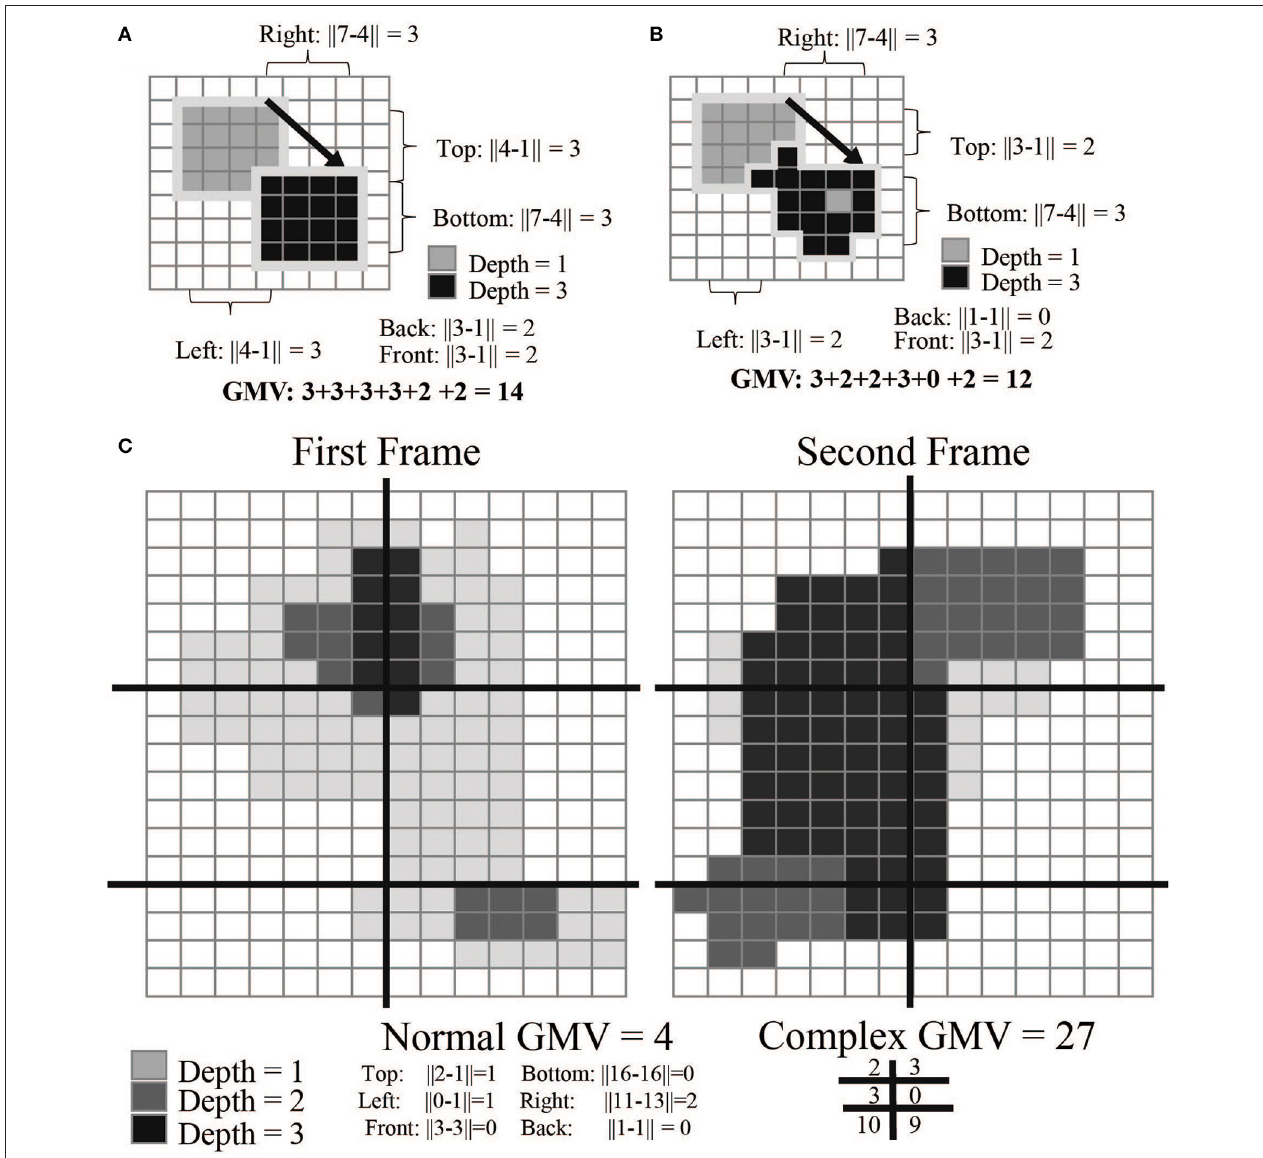
FIGURE 4 | GMV calculations. The gross movement value (GMV) is calculated by detecting changes in pixels between frames. In examples (A,B) , the arrow indicates the transition from frame 1 to 2; example C is split into two panels. The absolute differences between the rightmost, leftmost, top-most, bottom-most, front-most, and back-most pixels are added together to calculate the final GMV. Example (B) is more complex than example (A) : the GMV for the top left is higher as more of the mass of the object has moved. Example (C) most closely mimics the calculation done while the monkey is in the cage environment. Each frame is broken down into segments (here represented as 6 different quadrants). By calculating the GMV per quadrant, we can detect regions of higher movement activity. This is useful in creating event-triggered averages of the GMV over the course of a full experimental